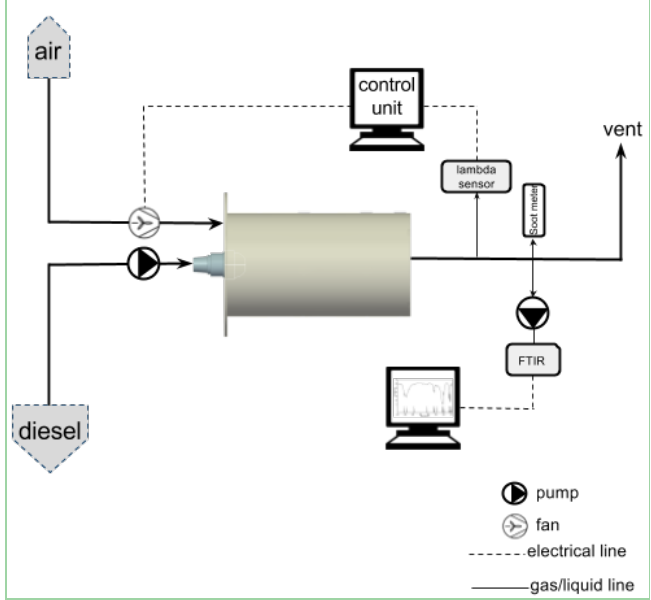
Figure 4. Simplified experimental setup. FTIR—Fourier-transform infrared spectroscopy.